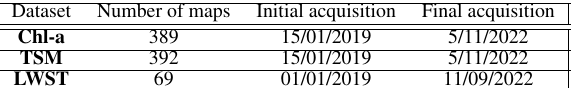
Table 1. Summary of available maps per dataset.